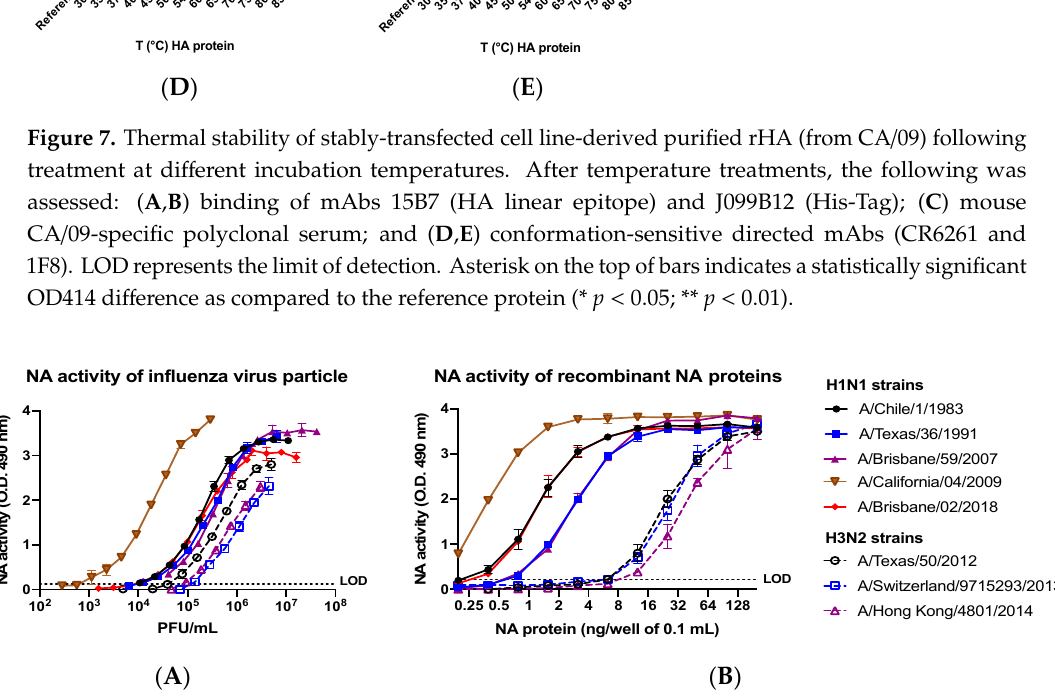
Figure 7. Thermal stability of stably-transfected cell line-derived purified rHA (from CA/09) following treatment at different incubation temperatures. After temperature treatments, the following was assessed: ( A , B ) binding of mAbs 15B7 (HA linear epitope) and J099B12 (His-Tag); ( C ) mouse CA/09-specific polyclonal serum; and ( D , E ) conformation-sensitive directed mAbs (CR6261 and 1F8). LOD represents the limit of detection. Asterisk on the top of bars indicates a statistically significant OD414 difference as compared to the reference protein (* p < 0.05; ** p < 0.01).